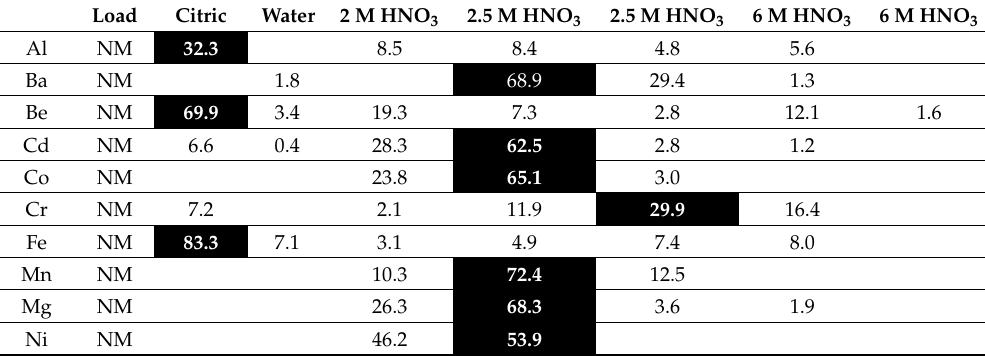
Table 1. Percentage of eluted elements in the various steps of the separation using the following rinse sequence: 5 mL of 1 M citric acid pH 2, 3 mL of water, 3 mL of 2 M nitric acid, 2 × 3 mL of 2.5 M nitric acid and 2 × 10 mL of 6 M nitric acid. Volume of Ag50 × 8 1 mL. Bolded values are the highest value for the elution of the element, and empty boxes represent samples that were < 1% or not detected. NM: not measured.